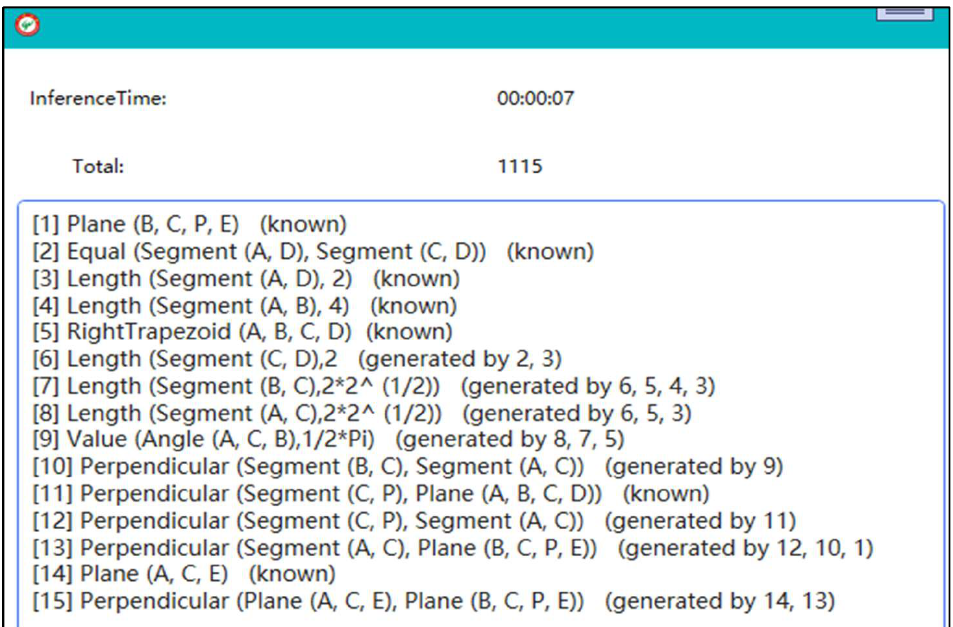
Figure 11. Results of second reasoning.